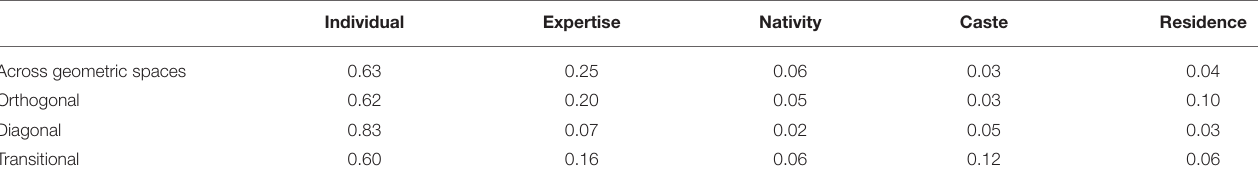
TABLE 2 | Explained variation (intraclass correlation). Individual